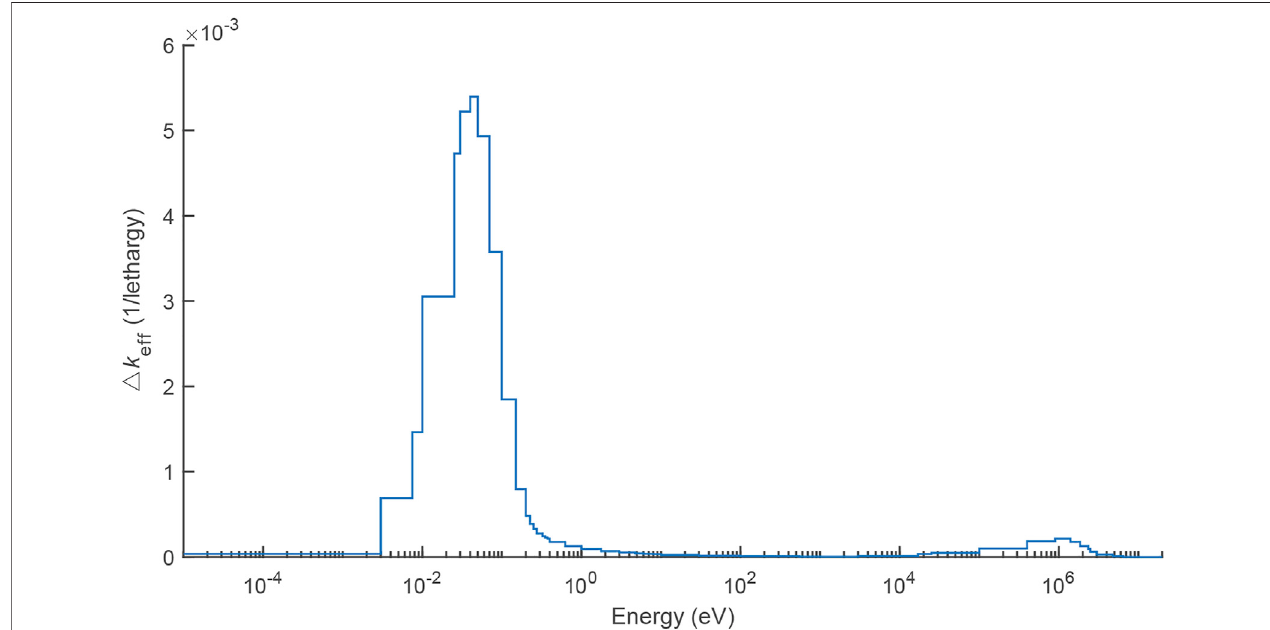
FIGURE 7 | Impact to by C-12 (n, γ )